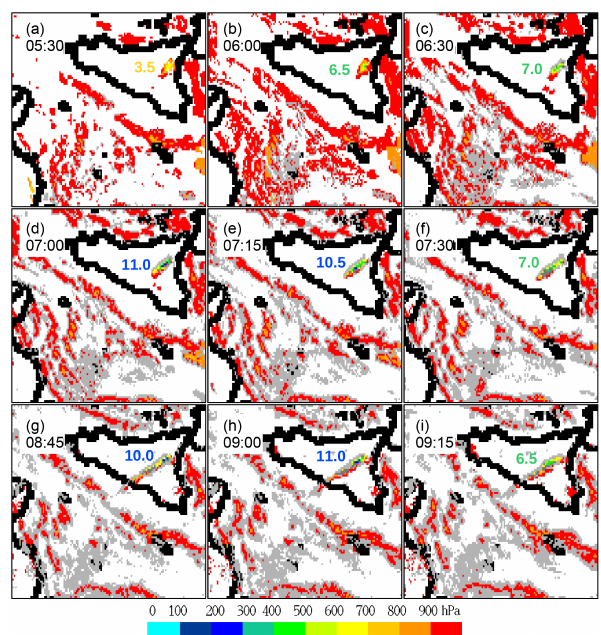
Figure 8. Cloud top pressure (in hPa) from SEVIRI, for 26 Oc- tober 2013. Blue and red pixels indicate relatively low and high pressure values. The start time of the SEVIRI scan is reported at the top/left corner of each image. The cloud top altitude is ob- tained by comparing pressure and altitude profiles using a quasi- coincident radio sounding at the WMO station in Trapani, Sicily, Italy (37.92 ◦ N, 12.50 ◦ E; 7m above sea level), and is reported (in km) and colour-coded in the images. Partially cloud covered pixels and very thin clouds, for which no pressure is available, are respec- tively in light grey and